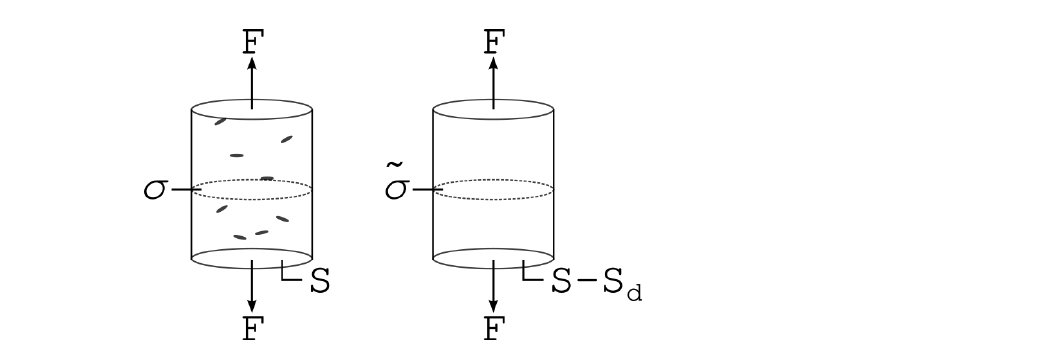
Figure 5. Nominal stress ( left ) and the continuum damage representation of the effective stress ( right